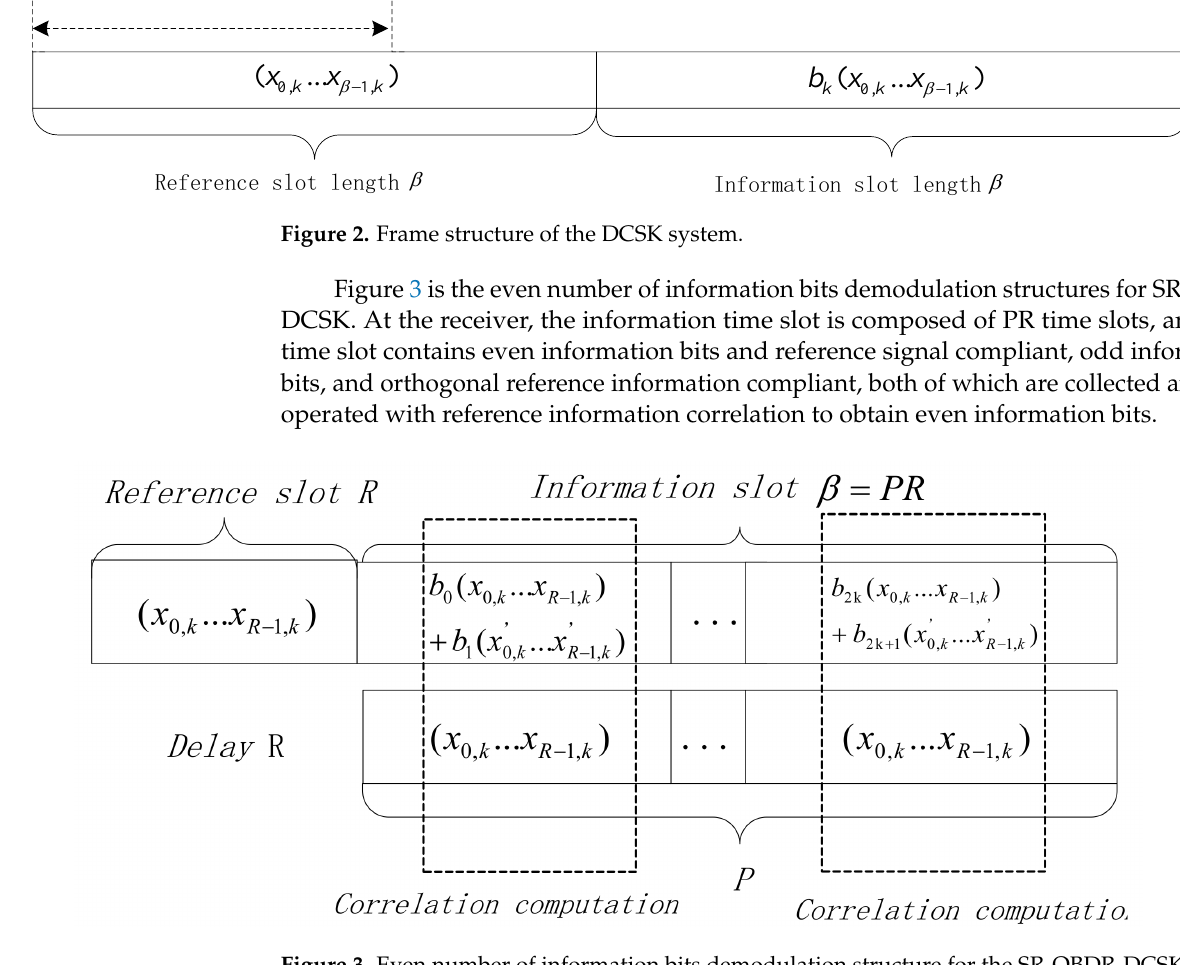
Figure 3. Even number of information bits demodulation structure for the